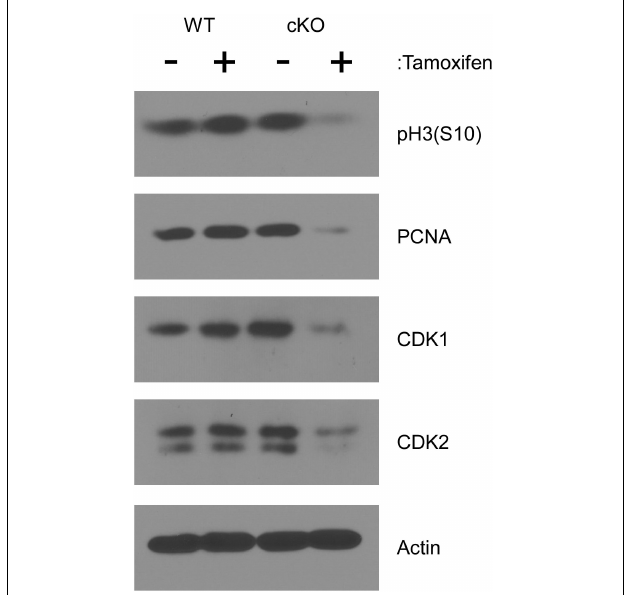
FIGURE 3 | NKAP deficiency in hematopoietic progenitor cultures leads to cell cycle withdrawal. Hematopoietic progenitor cells as described in Figure 2 were either treated with tamoxifen for four days or left untreated. Cell lysates were then prepared from equal numbers of cells and analyzed by western blotting with the antibodies indicated. Actin was analyzed as a loading control. Data shown is representative of results obtained from three independent experiments initiated from separate pairs of